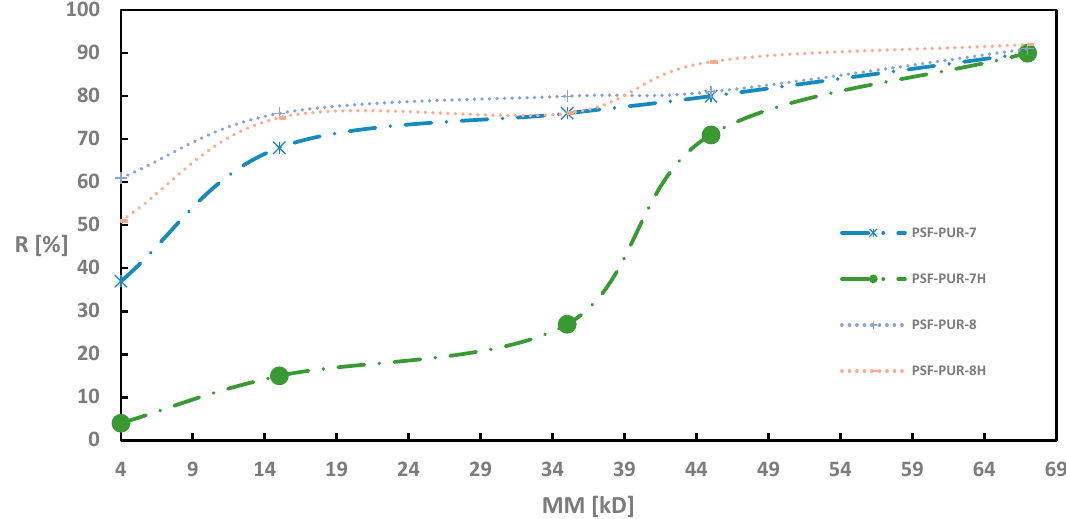
Figure 5. Retention coefficient values for different markers for PSF-PUR-7 and PSF-PUR-8 membranes before (PSF-PUR-7, PSF-PUR-8) and after (PSF-PUR-7H, PSF-PUR-8H) hydrolysis.